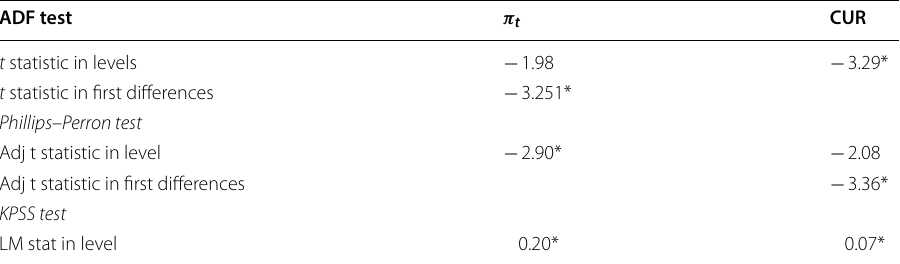
*Shows the statistical significance at the 1% level of significance